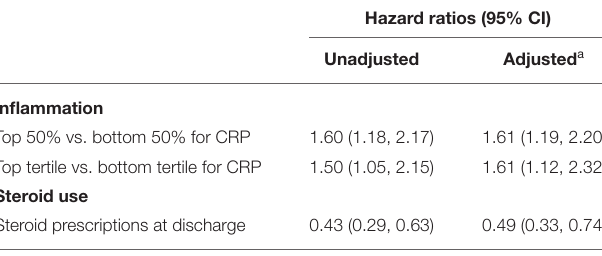
TABLE 2 | All-cause mortality hazard ratios by inflammation and steroid use. Hazard ratios (95%